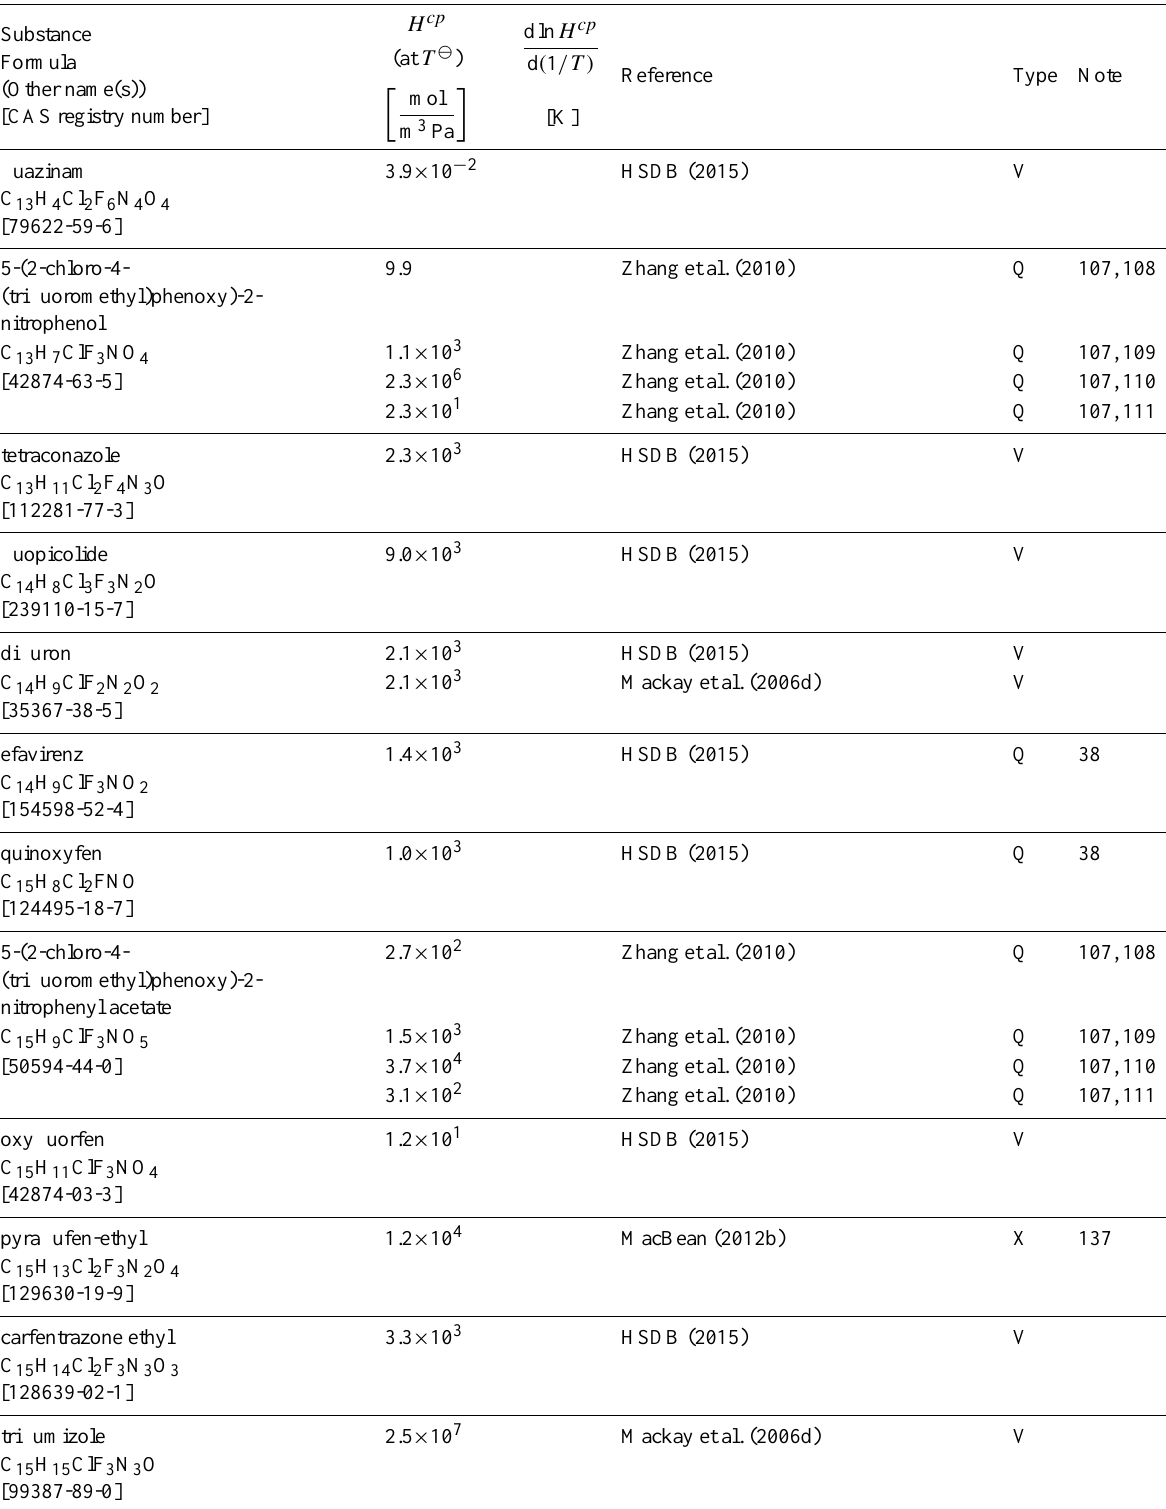
Table 6: Henry’s law constants for water as solvent